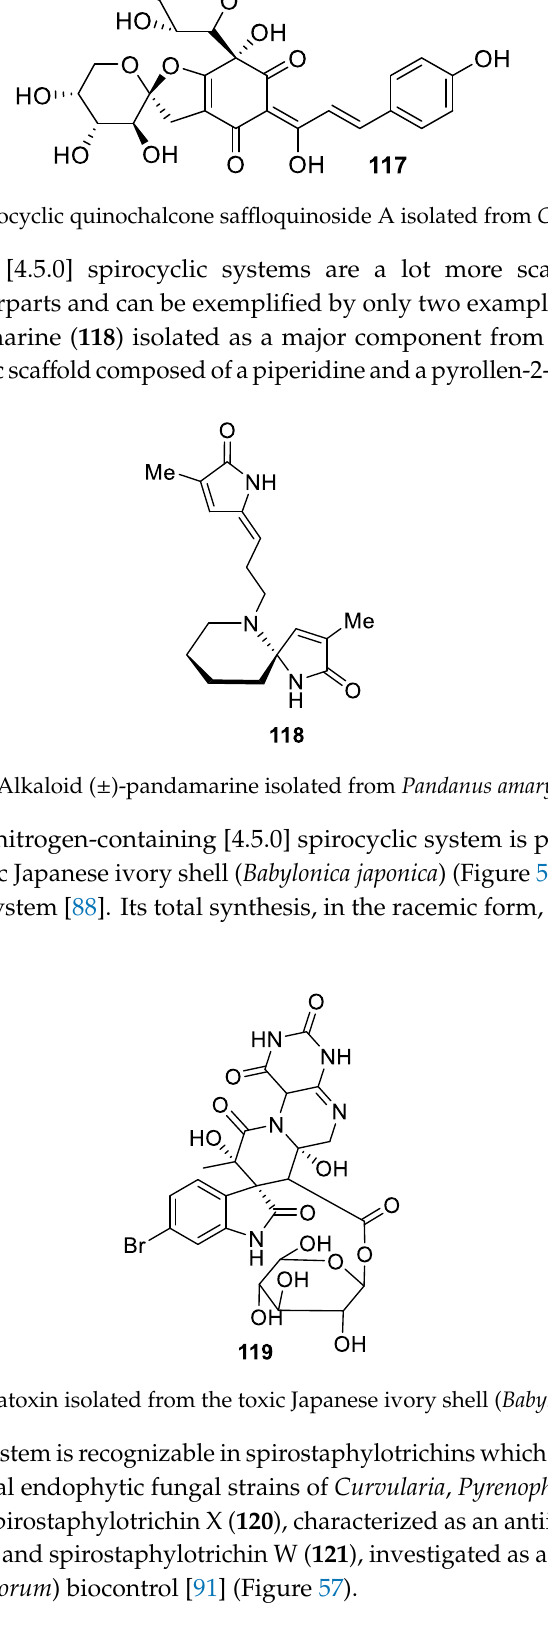
Figure 57. Structures of representative spirostaphylotrichins possessing a [4.5.0] spirocyclic motif. Summarizing this Section, the scaffold diversity stemming from the general [4.5.0] spirocyclic framework is comparable to that of the [4.4.0] spirocyclic system discussed earlier (Figure 30) and is shown in Figure 58.